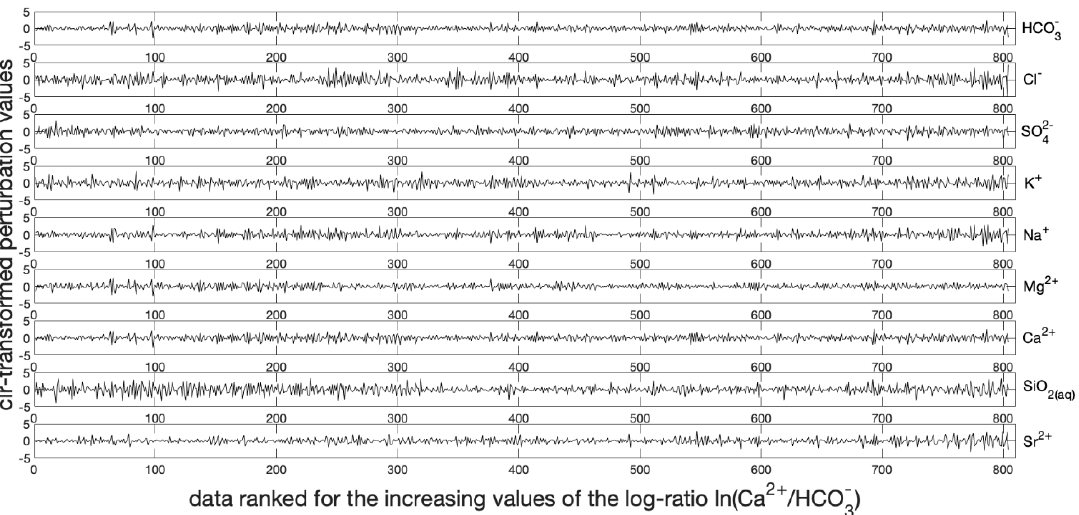
Figure 2. Pattern of the clr-transformed perturbation-subtraction values after having ranked the data matrix for the increasing values of the log-ratio ln(Ca 2 + / HCO 3 − ). The nitrogen component was eliminated by the data matrix.